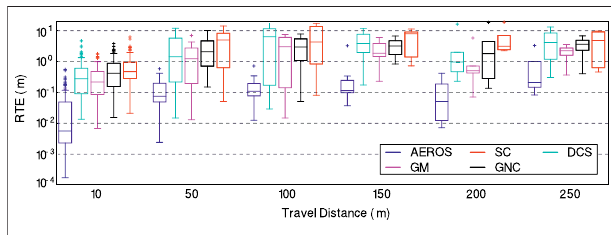
FIGURE 9 | Comparison of AEROS versus the other approaches, DCS, SC, GM and GNC on the NCD real data. Relative Translation Errors (RTE) are measured over various intervals of the trajectory of length 10, 50, 100, 150, 200, 250 m.